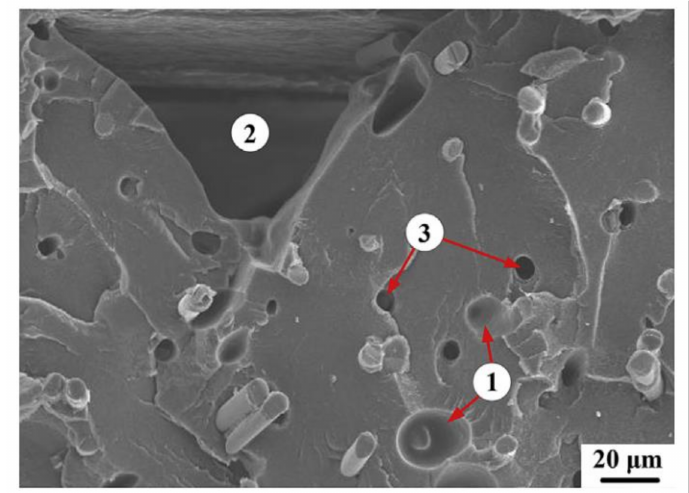
Figure 10. Illustration of different categories of porosity in a short fiber reinforced specimen. Reprinted with permission from [28]. Copyright 2015, Elsevier.